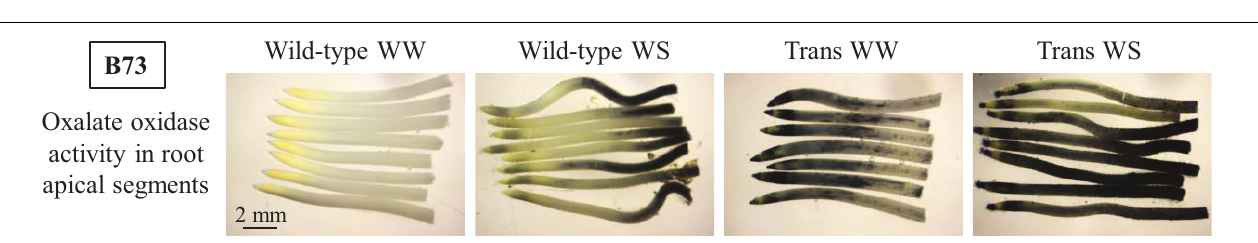
FIGURE 1 | Oxalate oxidase activity and apoplastic ROS in the apical region of the primary root in CK44 oxalate oxidase transgenic (Trans) and wild-type lines at 48 h after transplanting to well-watered (WW) or water-stressed (WS; –1.6 MPa) conditions. Oxalate oxidase activity was measured by oxidation of 4-chloro-1-naphthol, seen as dark blue staining, in approximately 12-mm apical segments (A) and in 14- µ m transverse sections at various distances from the root apex (B) . Apoplastic ROS (C) was stained using the fluorescent ROS indicator H 2 DCF (membrane impermeable); confocal images of the epidermis at 1.5–2.0 mm from the root apex are shown. The images are composed of projections of seven consecutive optical sections (5 µ m in thickness) obtained by two-photon confocal microscopy. The numbers on the images indicate normalized pixel intensities ( ± SE; n = 3 roots) of a 0.04 mm 2 area of the root (0.18 mm length, 0.23 mm width), as illustrated in the Trans WS image. Different letters indicate significant differences ( t -test; P < 0.05). All experiments were repeated with similar results, and representative images are shown. Panel D shows a schematic representation of apoplastic ROS imaging in the epidermal cell file (D) . Green and black semicircles indicate the apoplast and cytoplasm of the epidermal cells, respectively, and blue lines indicate the consecutive optical planes at which fluorescence was captured. The schematic also illustrates the curvature of the root, which necessitated capture of fluorescence in multiple optical planes.